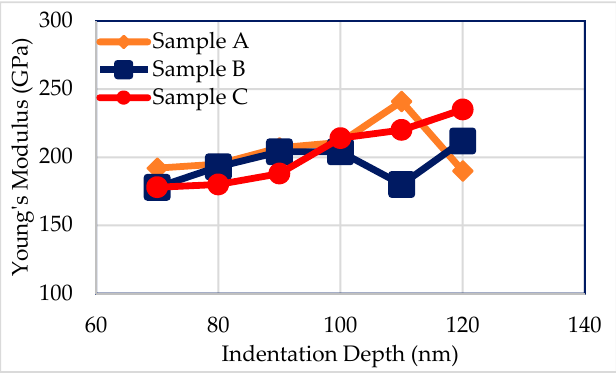
Figure 6. Young’s modulus with various indentation depth of 500 nm IGZO thin films.